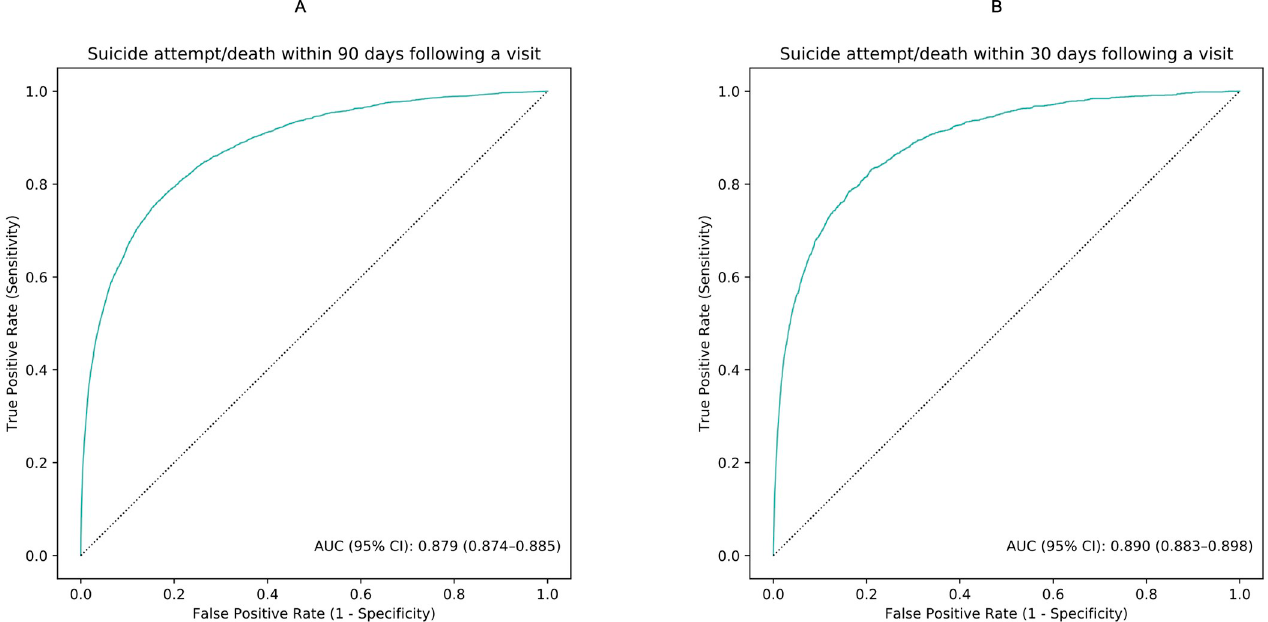
Fig 1. ROC curves illustrating model discrimination accuracy in the test set for predicting suicide attempt/death within 90 (A) and 30 days (B) following a visit to psychiatric specialty care during 2011 and 2012. The figure was based on the discrimination accuracy of the ensemble models. The solid line in brown represents the ROC curves achieved by the models. The dotted line in black represents the ROC curves when AUC equals 50%. AUC, area under the receiver operating characteristic curves; ROC, receiver operating characteristic.